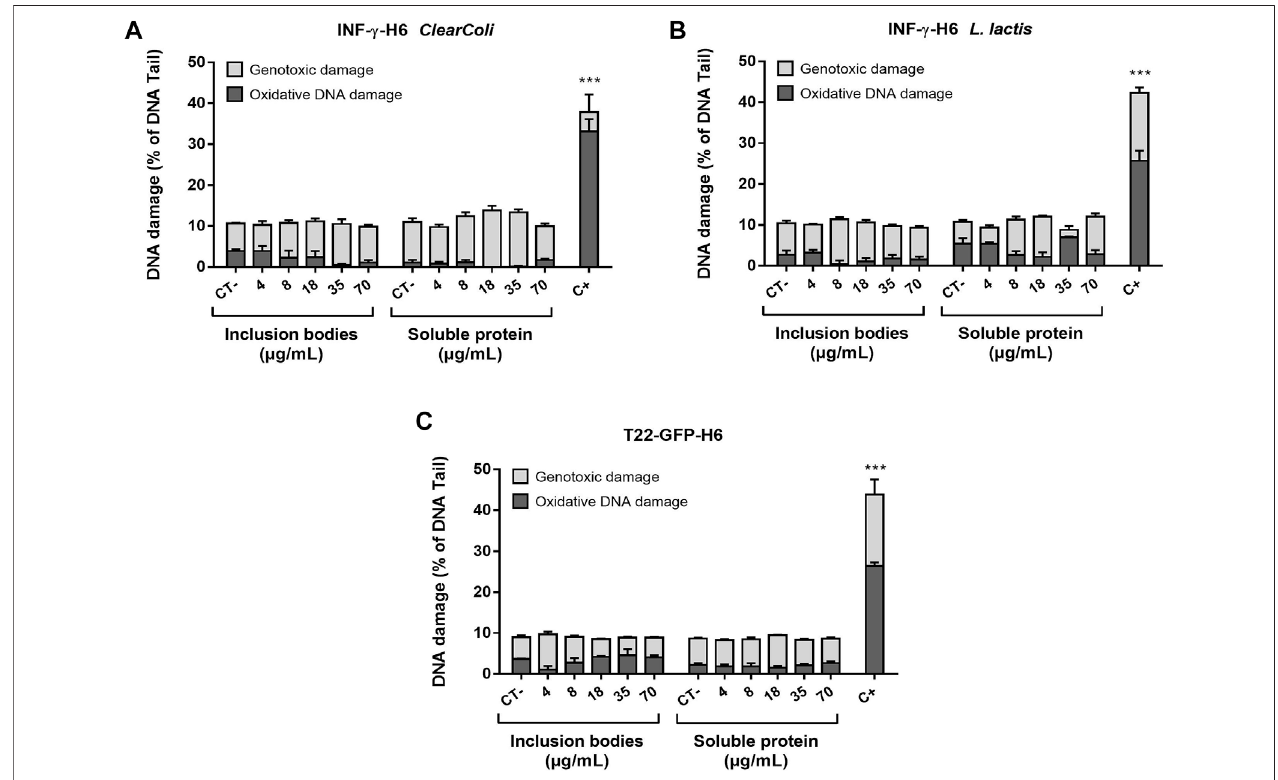
FIGURE 2 | Genotoxic and oxidative DNA damage induced by the recombinant proteins. DNA damage level on cells exposed to increasing doses of (A) INF- γ -H6 from ClearColi ® , (B) INF- γ -H6 from L. lactis , and (C) T22-GFP-H6 after 24 h. 1 h exposure to MMS (200 μ mol/L) was used as a positive control. Data are presented as mean % of DNA quanti fi ed in the comet tail